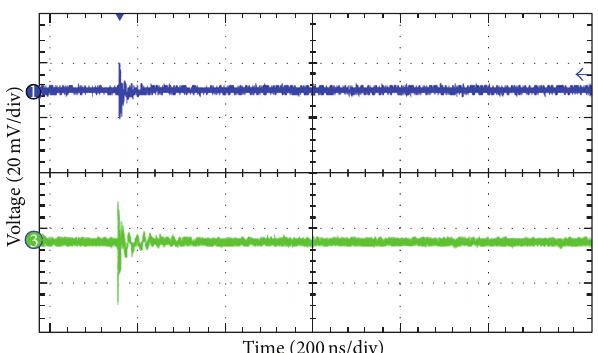
Figure 12: UHF signals measured by the rectangular spiral antenna and a quasi-TEM horn antenna.